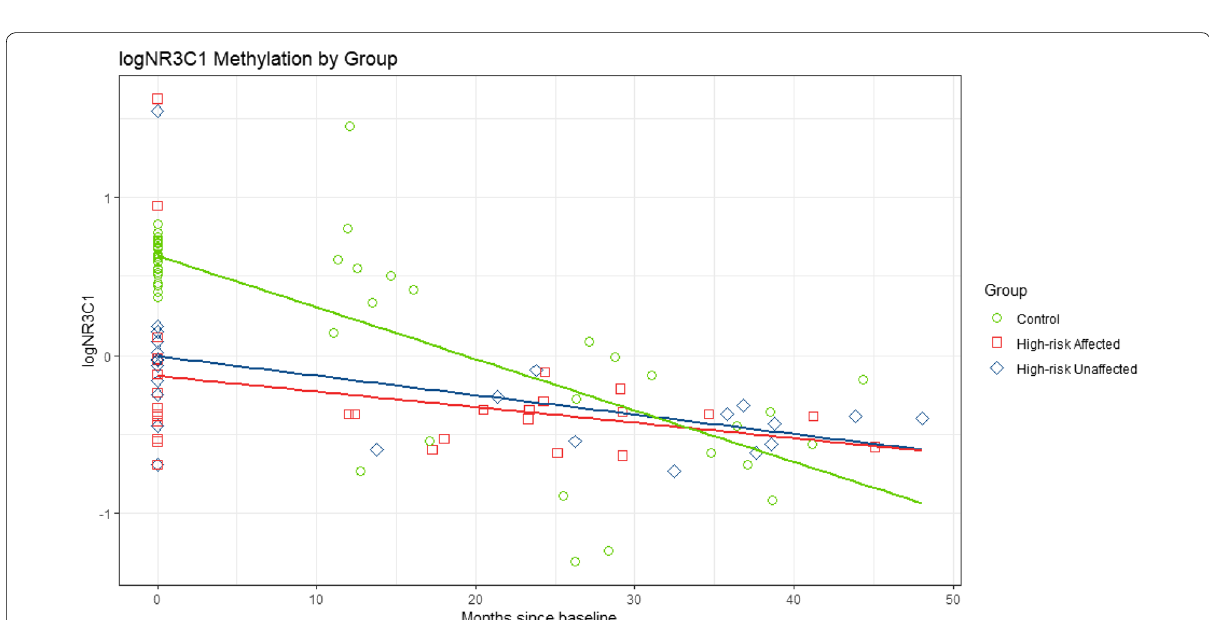
Fig. 3 Log NR3C1 methylation percentage by study group from the longitudinal model between Time 1 and tIme 2. Estimated longitudinal profiles of log NR3C1 methylation rates. After adjustment, there was evidence that the rate of decrease in controls (green) is steeper than the rate of decrease of unaffected HR (blue) (p change over time in affected HR (red) was different from unaffected HR (blue) (p